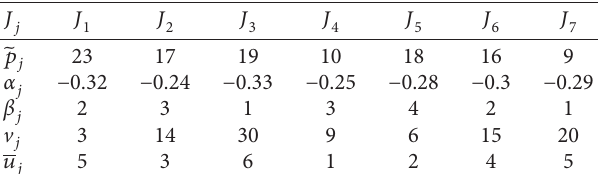
Table 1: Data for Example